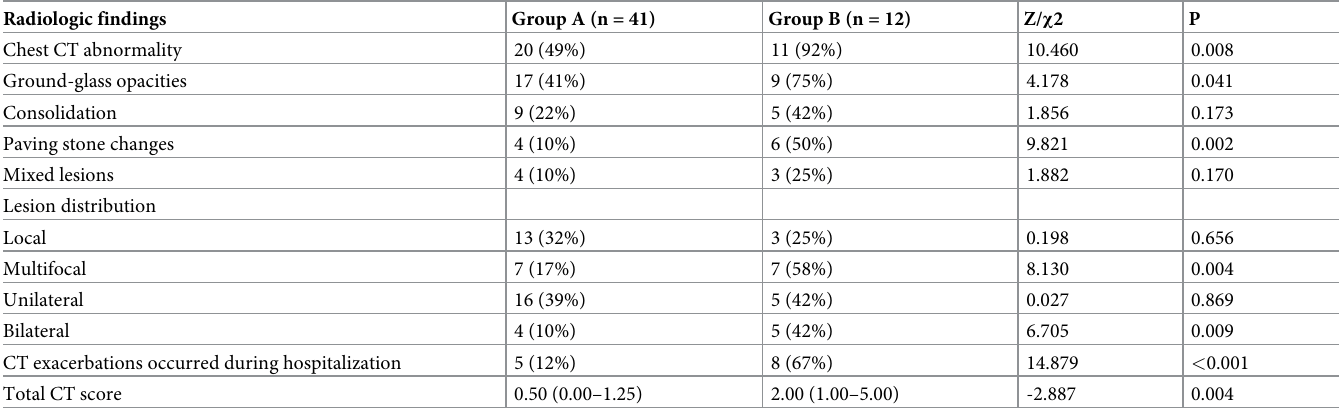
Table 4. Imaging outcomes of the two groups.